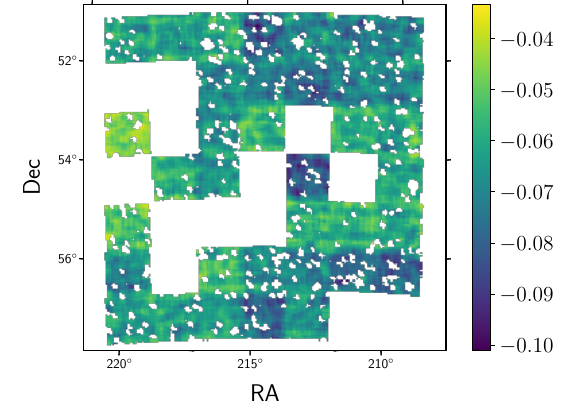
Figure 3. Map of the multiplicative corrections ( m p ) for the W3 field and the sixth redshift bin.